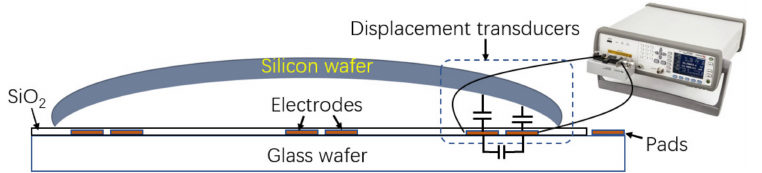
Figure 2. Schematic of multi-grid capacitive transducers for measuring wafer surface profile.